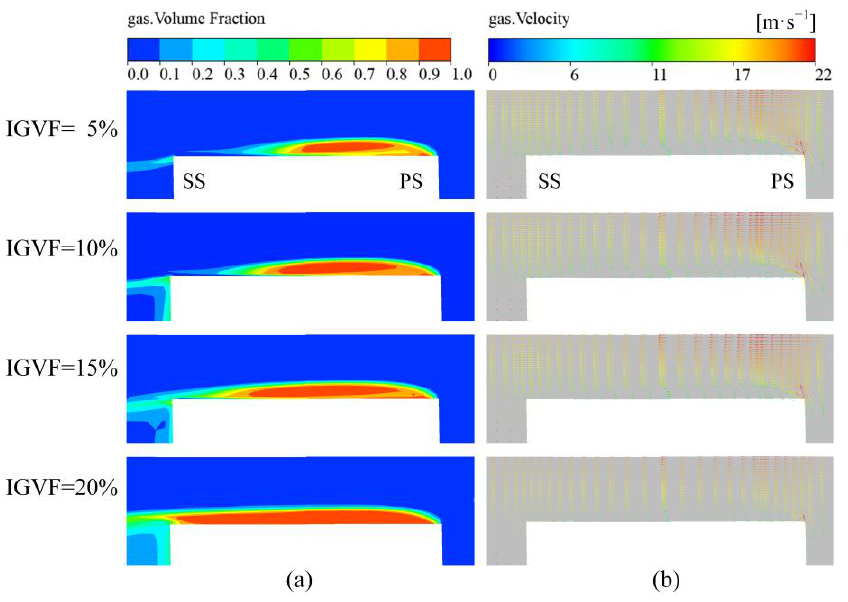
Figure 15. Gas volume fraction and velocity vector in the tip clearance. ( a ) Gas volume fraction and ( b ) velocity vector.